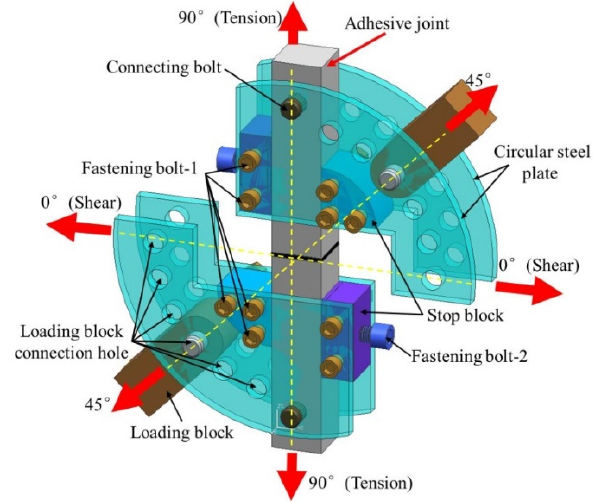
Figure 4. Schematic diagram of Arcan fixture.